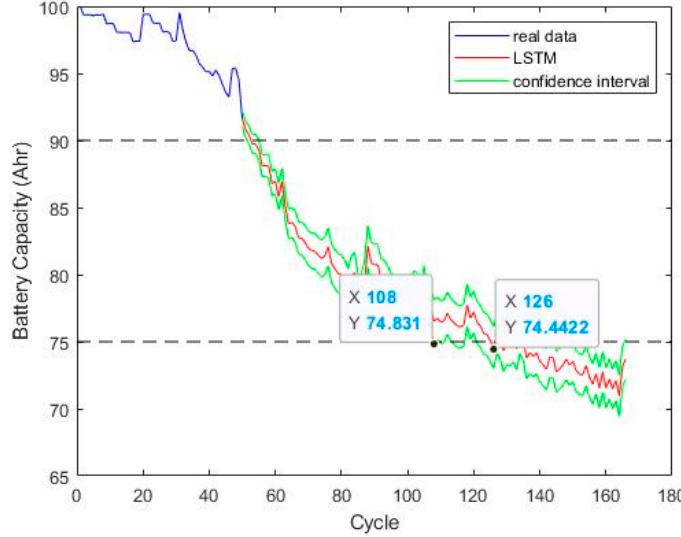
Figure 17. Prediction analysis and remaining useful life with LSTM.